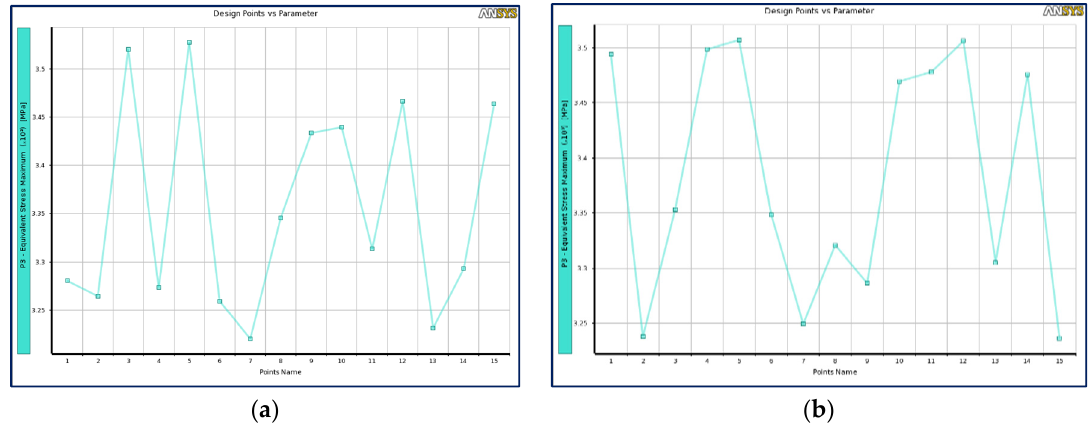
Figure 16. Equivalent stress vs. design points ( a ) for CCD scheme ( b ) for optimal space filling design.